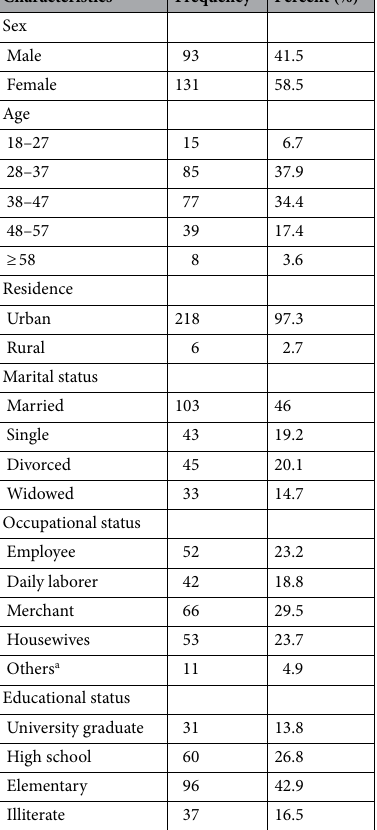
Table 1. Sociodemographic characteristics of people living with HIV who were attending Hawassa University Comprehensive Specialized Hospital ART clinic, Hawassa, Ethiopia, from September 17 to November 16, 2018 (n = 224). a Others: driver, student and